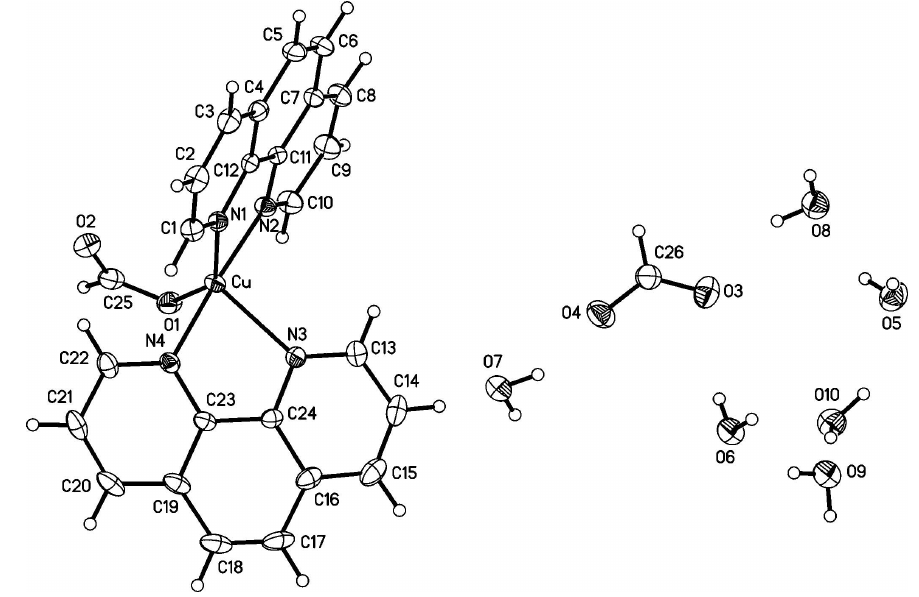
Figure 1 The molecular structure of the title complex showing 40% probability displacement ellipsoids.